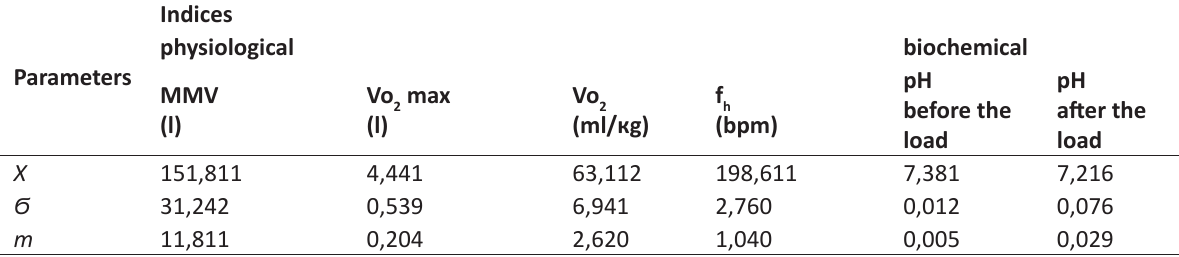
Table 1. The indices of the maximum functional capabilities of the cardiorespiratory system of the organism of cyclists in step-increasing load to full